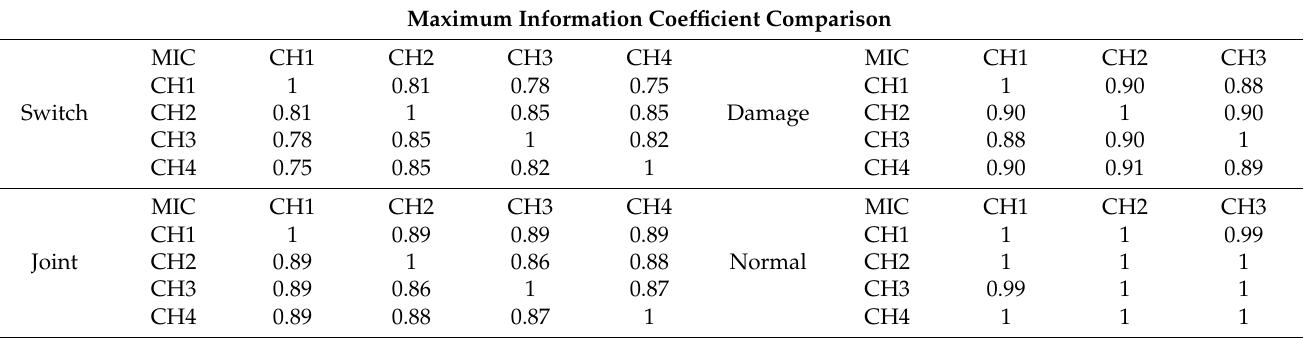
Table 8. The maximum information coefficient (MIC) of different channels under different rail states. Maximum Information Coefficient Comparison